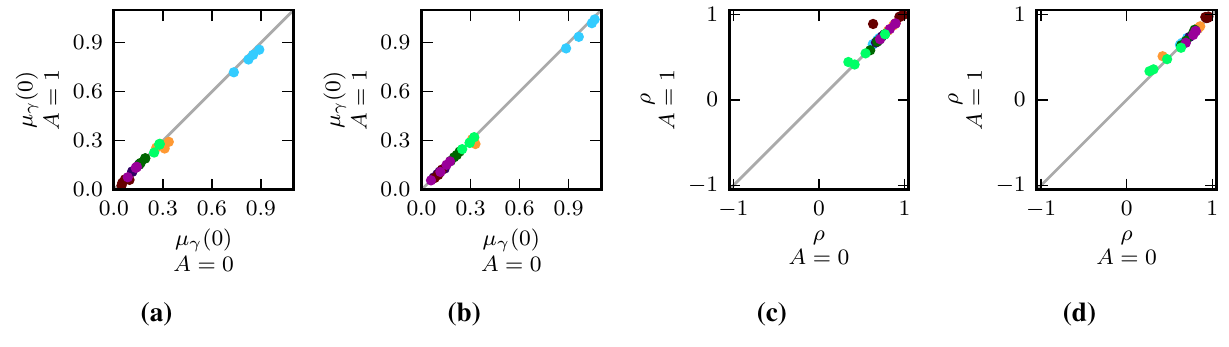
Figure 10. Comparison of phase correlation and misfit for HH and VV between A “ 0 and A “ 1 , using the Hal mixing model. The median values of the estimated a (HH) and –0.06 (VV). Refer to Figure 6 for the colour code. ( a ) Misfit φ ( c ) Correlation φ ; ( d ) Correlation φ HH V V